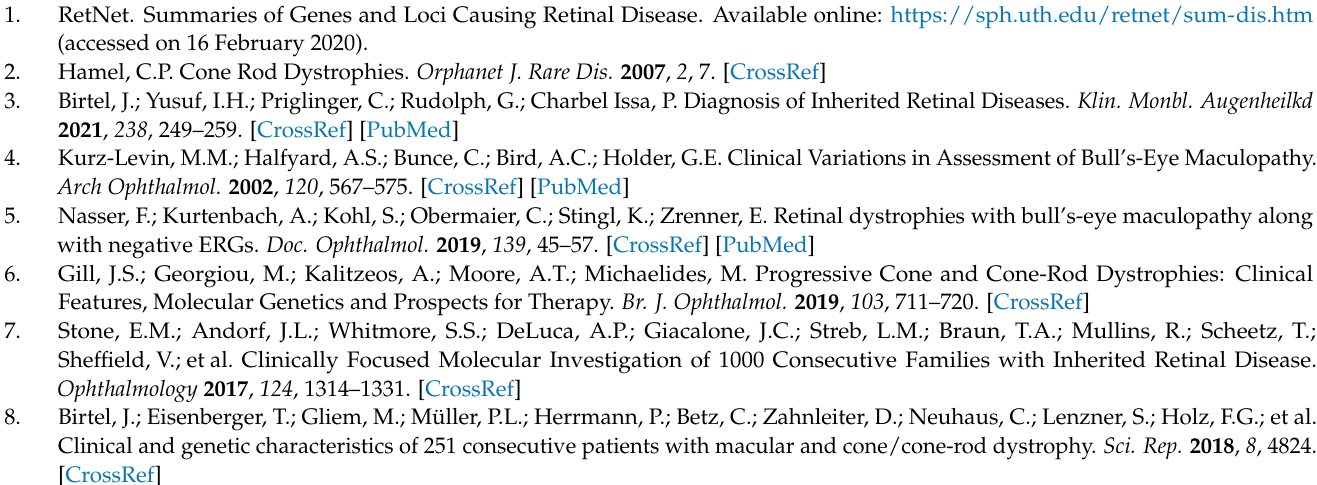
overview of different autofluorescence patterns. Figure S3: visual acuity values (OD and OS) associ- ated with age in GUCY2D -related AD COD/CORD patients who have been examined more than once. Figure S4: linear regression of visual acuity values (OD) associated with age in patients with p.(Arg838Cys) ( n = 85) and p.(Arg838His) ( n = 38). Table S1: clinical data of 25 GUCY2D -related AD COD/CORD